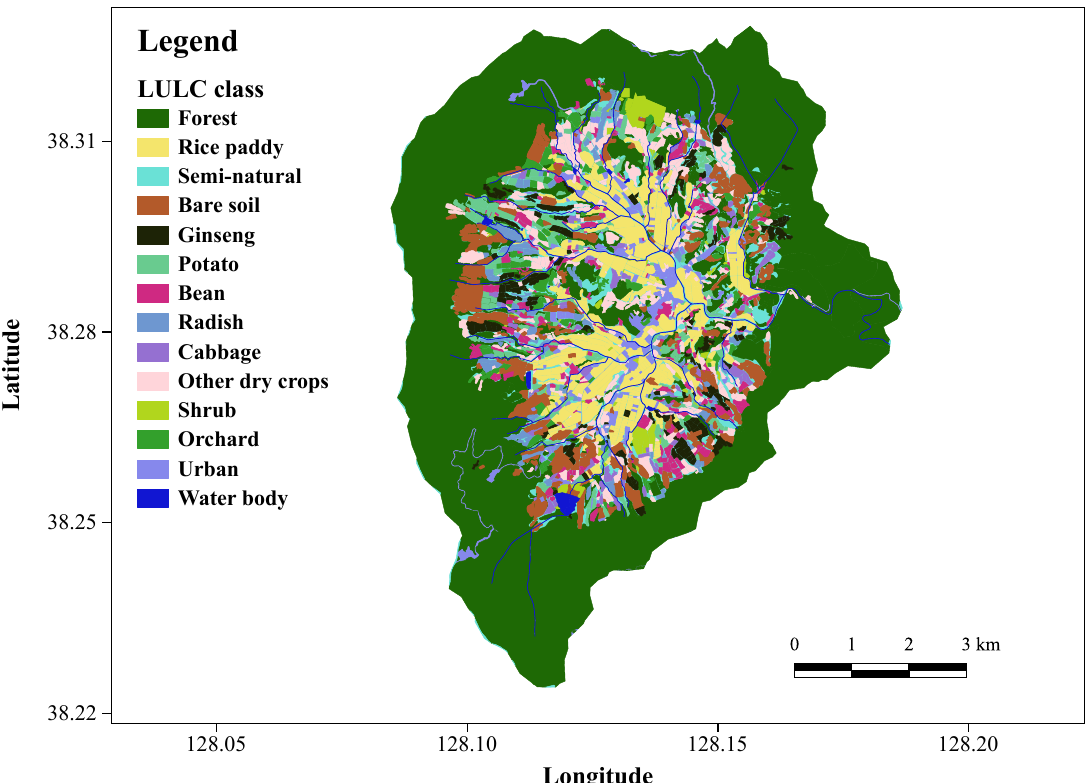
Figure 5. LULC classes and their spatial configurations for the Haean catchment in the year 2010 [35]. We classified the original LULCs into 14 categories (i.e., forest, rice paddy, semi-natural, bare soil, ginseng, potato, bean, radish, cabbage, other dry crops, shrub, orchard, urban, and water bodies). Forest, rice paddy, semi-natural, bare soil, ginseng, potato, bean radish, and cabbage are major LULCs that covered more than 1% of the catchment area. Minor LULCs were aggregated into groups of other dry crops, shrub, orchard, urban, and water bodies according to their physical characteristics. We used field measurement data of CC , PH , NV , IMP , d a , and n for major dry crops such as bean, cabbage, potato, and radish, whose data were obtained from the field campaign of the TERRECO project, which was also used in Arnhold et al. [17]. The daily forest CC was estimated using the average values of 8-day normalized difference vegetation index (NDVI) for forest in the catchment from MODIS [45,46]. The average NDVI values were converted to canopy cover ( CC ), using the equation suggested by Gutman and Ignatov [47]. LULC parameters for rice and ginseng, and the average diameter of individual plant elements ( D ) for major dry crops were obtained from agricultural technology portal provided by Rural Development Administration of South Korea (RDA) [48]. The average LULC parameters of major dry crops were used for the LULC parameters of other dry crops, while the guide values from Morgan and Duzant [40] were adopted for other LULC parameters. Detailed initial parameter settings are presented in Table